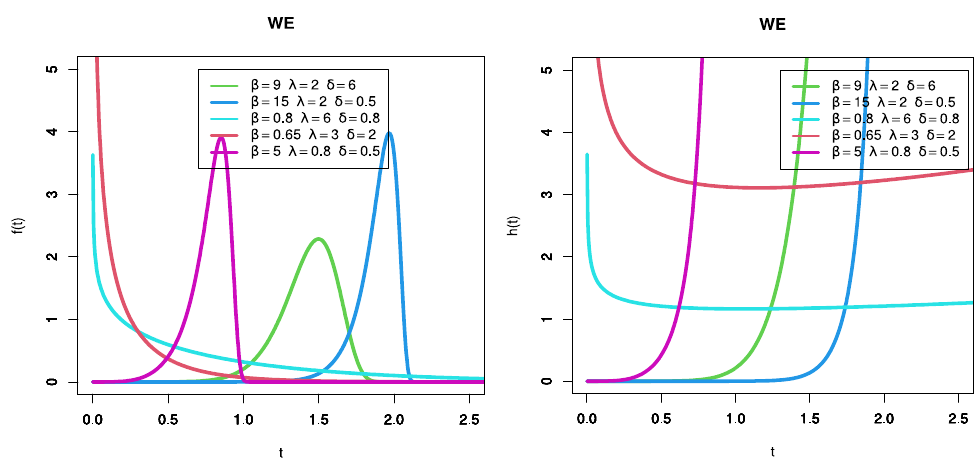
Figure 1. Different possible shapes of the WE density and hazard function for several parametric